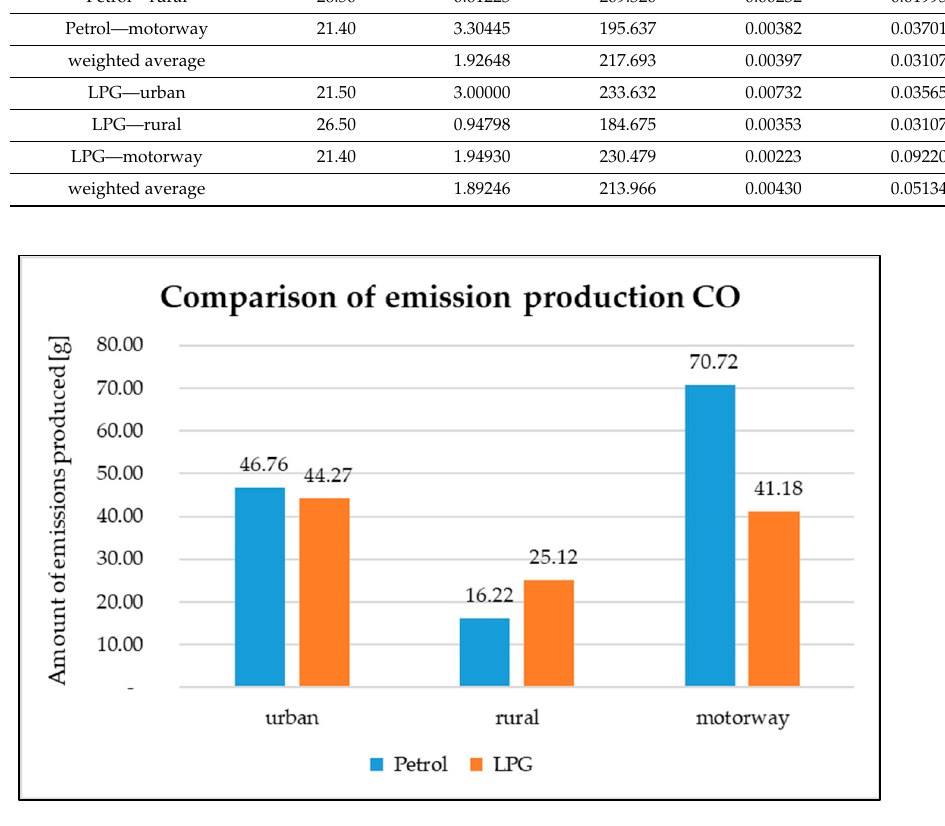
Figure 12. Comparison of CO production [measurement results processed by the author].